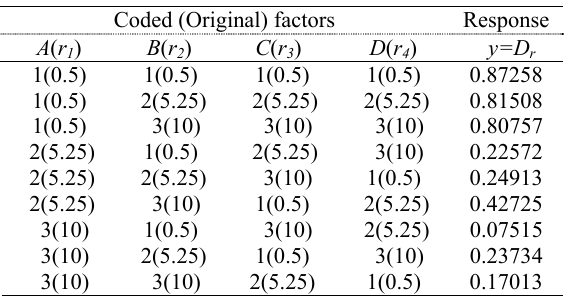
Table 3. Taguchi L 9 (3 4 ) orthogonal array with response Coded (Original) factors